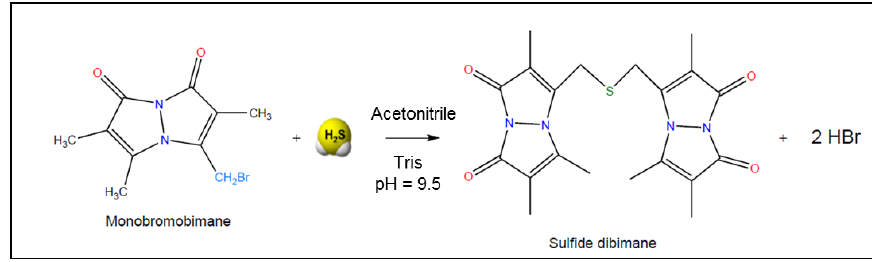
Figure 9. Monobromobimane derivatization reaction. Modified from Shen et al. [168]. In order to quantify the formation of sulfide dibimane in a sample, the next step is RP-HPLC with monitoring of UV absorption (254 nm) and fluorescence (lex = 390 nm, lem = 475 nm). In the studies by Wintner et al., formation of sulfide dibimane was followed by monitoring fluorescence intensity over 5 min [35].